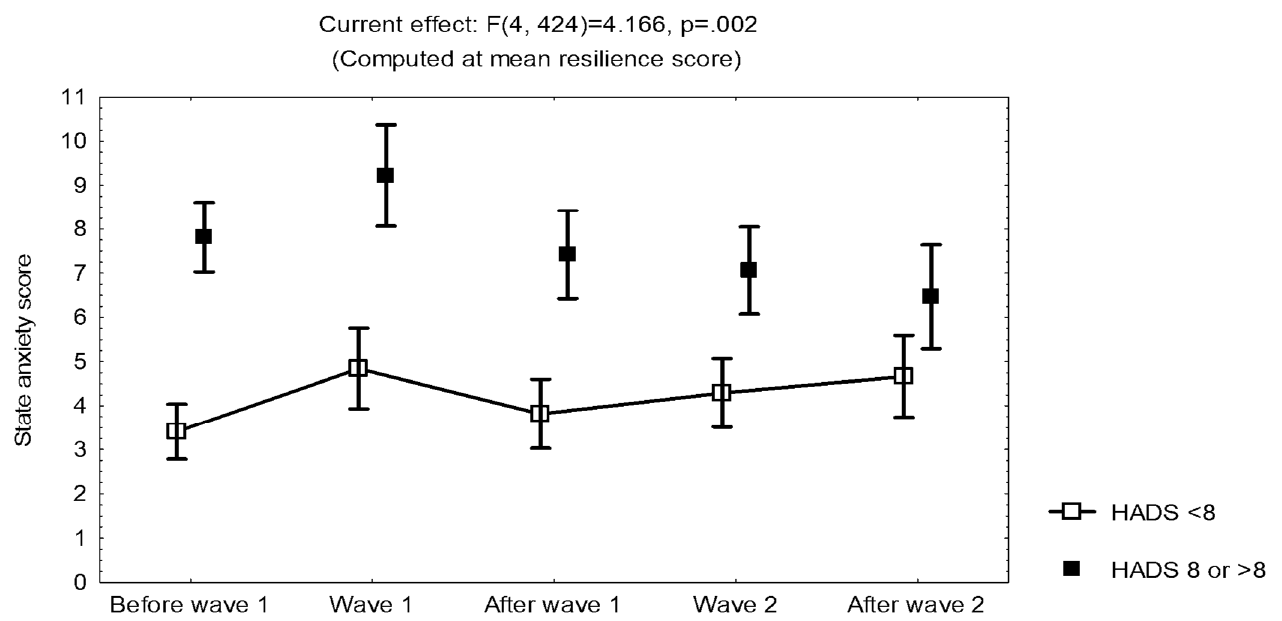
Figure 3. Mean and standard error of the mean of the scores on the State-Trait Anxiety Inventory (short version) during the evaluations in Group I ( n = 109), according to the score on the Hospital Anxiety and Depression Scale (HADS) (<8 or ≥ 8).